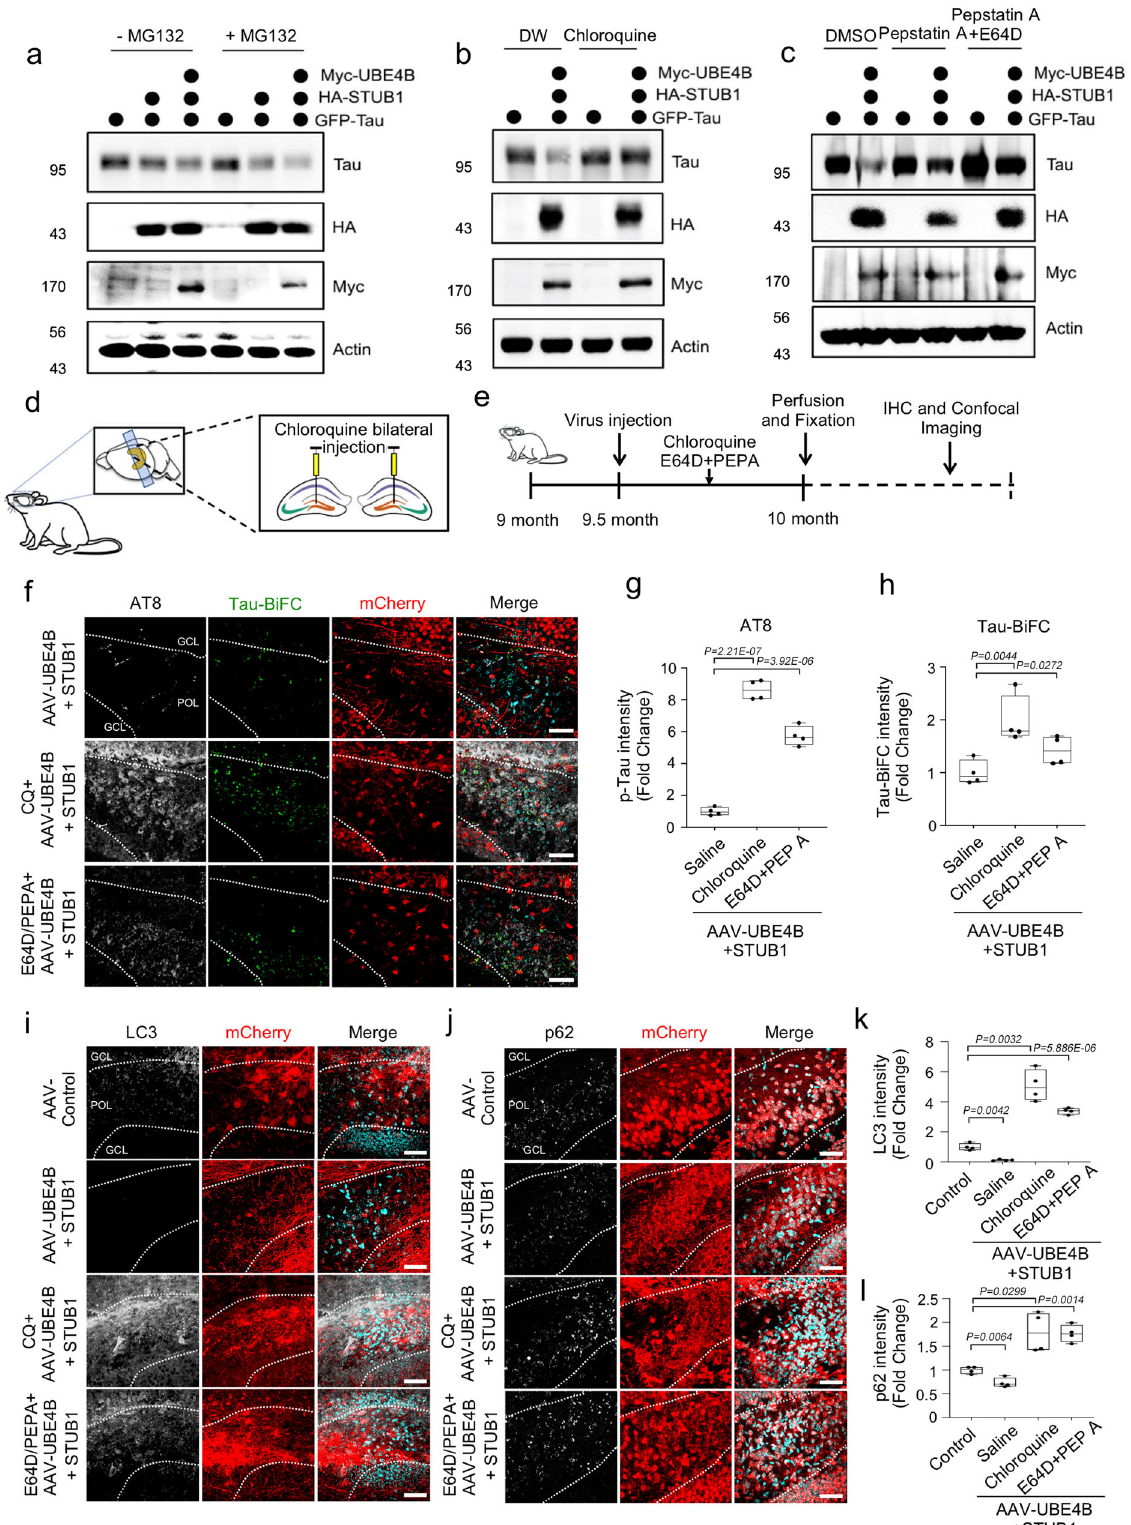
Digiretina 16 camera, and eye size was measured using Image J v1.44 software (National Institutes of Health, Bethesda, USA). Values obtained from these mea- surements were plotted using a volcano plot in Graphpad Prism